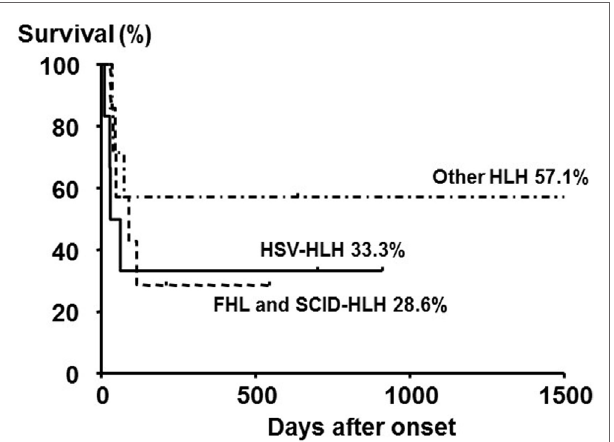
FiGURe 5 | Survival of patients with eBv-HLH . Outcome of patients with EBV-HLH having both hyperbilirubinemia and hyperferritinemia at diagnosis was significantly poorer than for those having low bilirubin and ferritin levels. Adapted from Kogawa et al. (44). Permission granted by John Wiley and